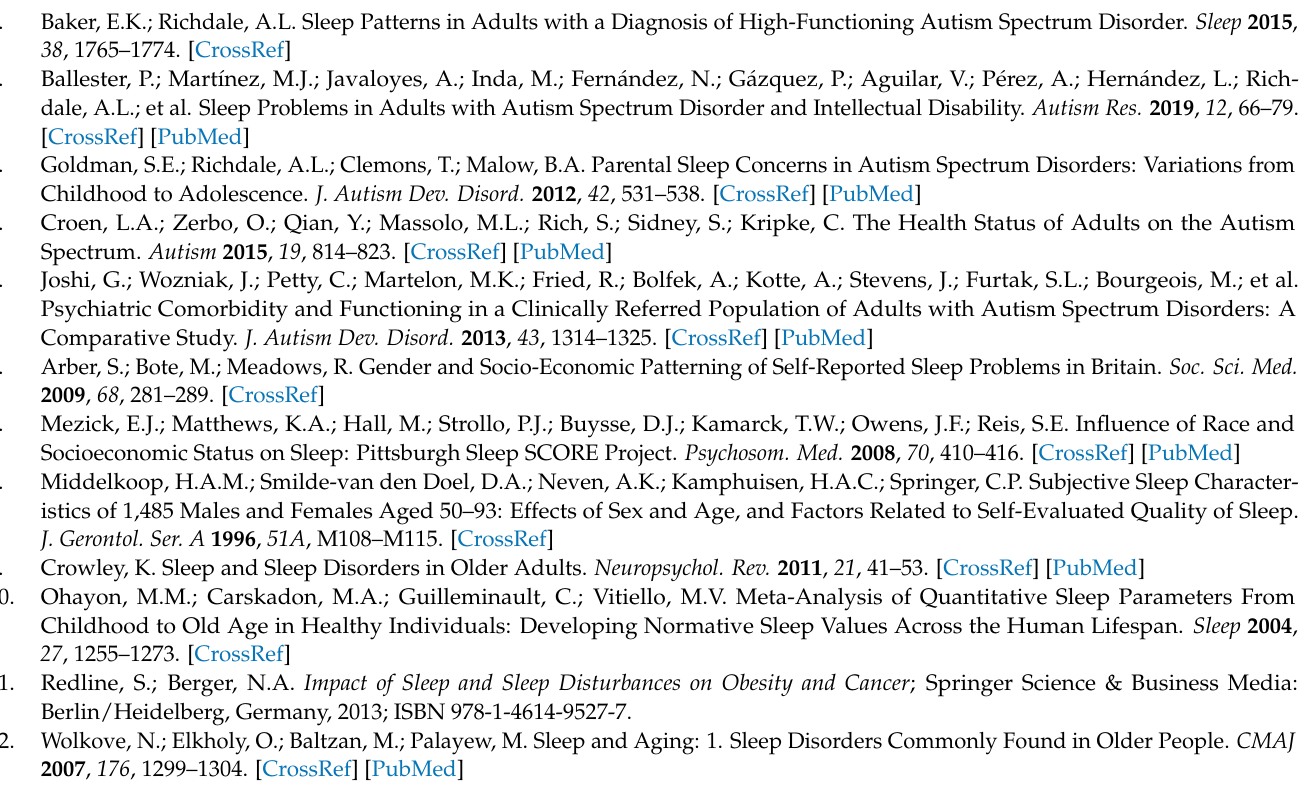
teristics, Table S2: Summary of autistic adults’ diagnoses, Table S3. Summary of autistic adults’ medication use. Table S4: Final sample size for each linear regression